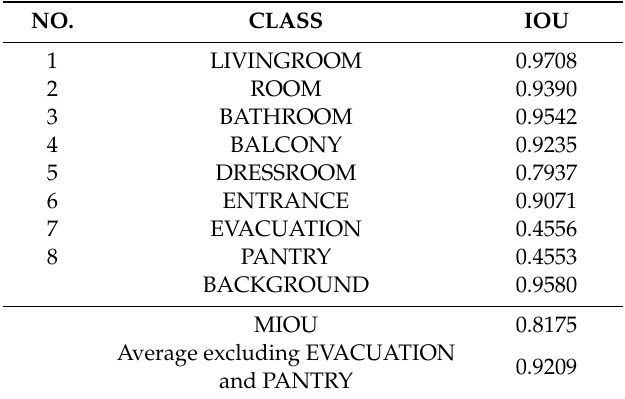
Table 5. IOU of experiment2.